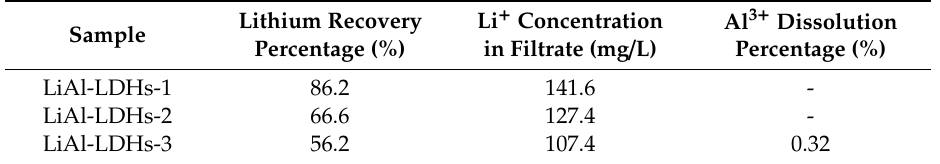
Table 3. Analyses on the solution after lithium recovery from LiAl-LDHs at varied initial Li + concentrations.